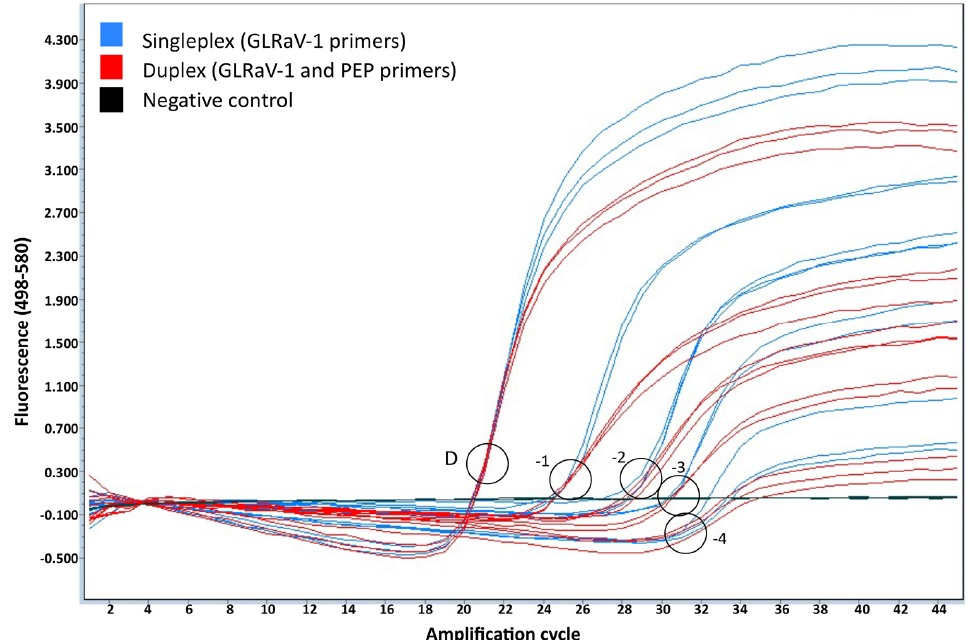
Figure 3. Validation of a grapevine internal control in a GLRaV-1 duplex real-time RT-PCR assay. Three independent replicates of a GLRaV-1 infected plant extract diluted with healthy plant extracts were assayed. GLRaV-1 amplification plots are shown for singleplex (blue) and duplex (red) reactions. A negative control (black) is included. PEP: phosphoenolpyruvate carboxylase; D: undiluted plant extract. − 1:10 − 1 dilution. − 2:10 − 2 dilution. − 3:10 − 3 dilution. − 4:10 − 4 dilution.